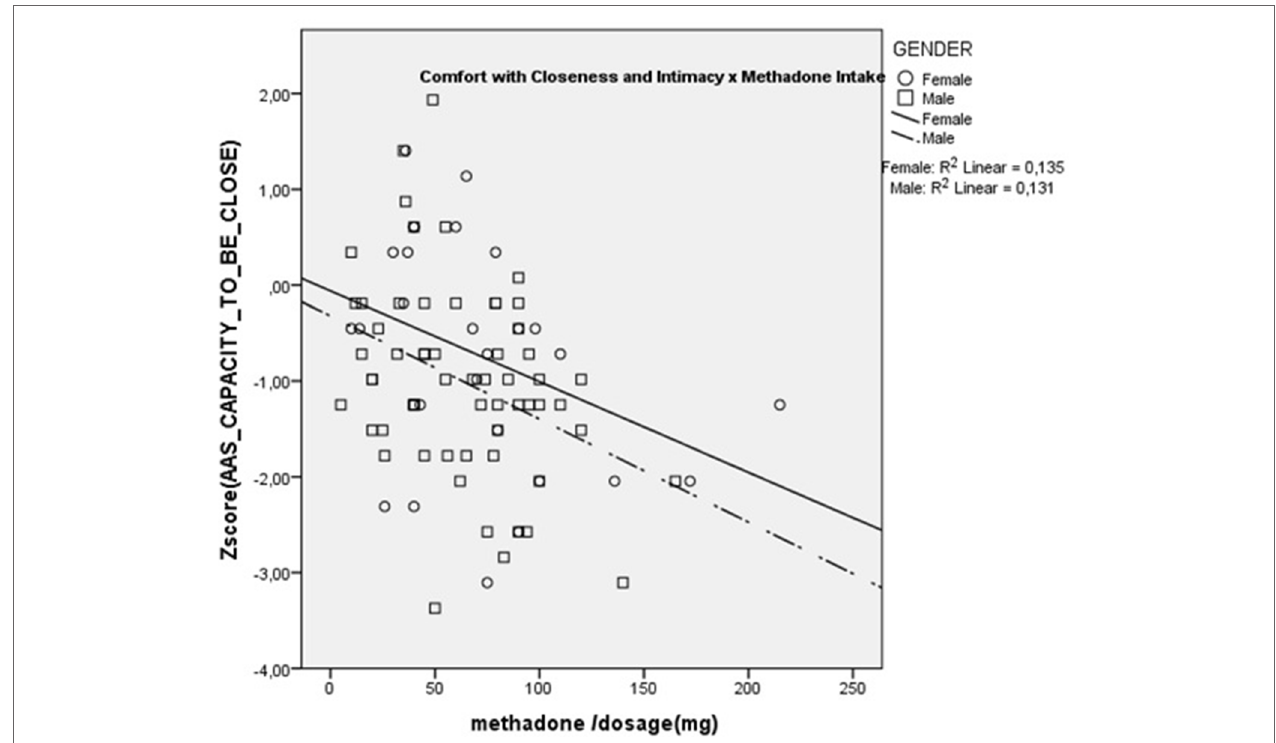
FIGURE 1 | Scatterplot of Correlation between methadone dose and Capacity to be Close.